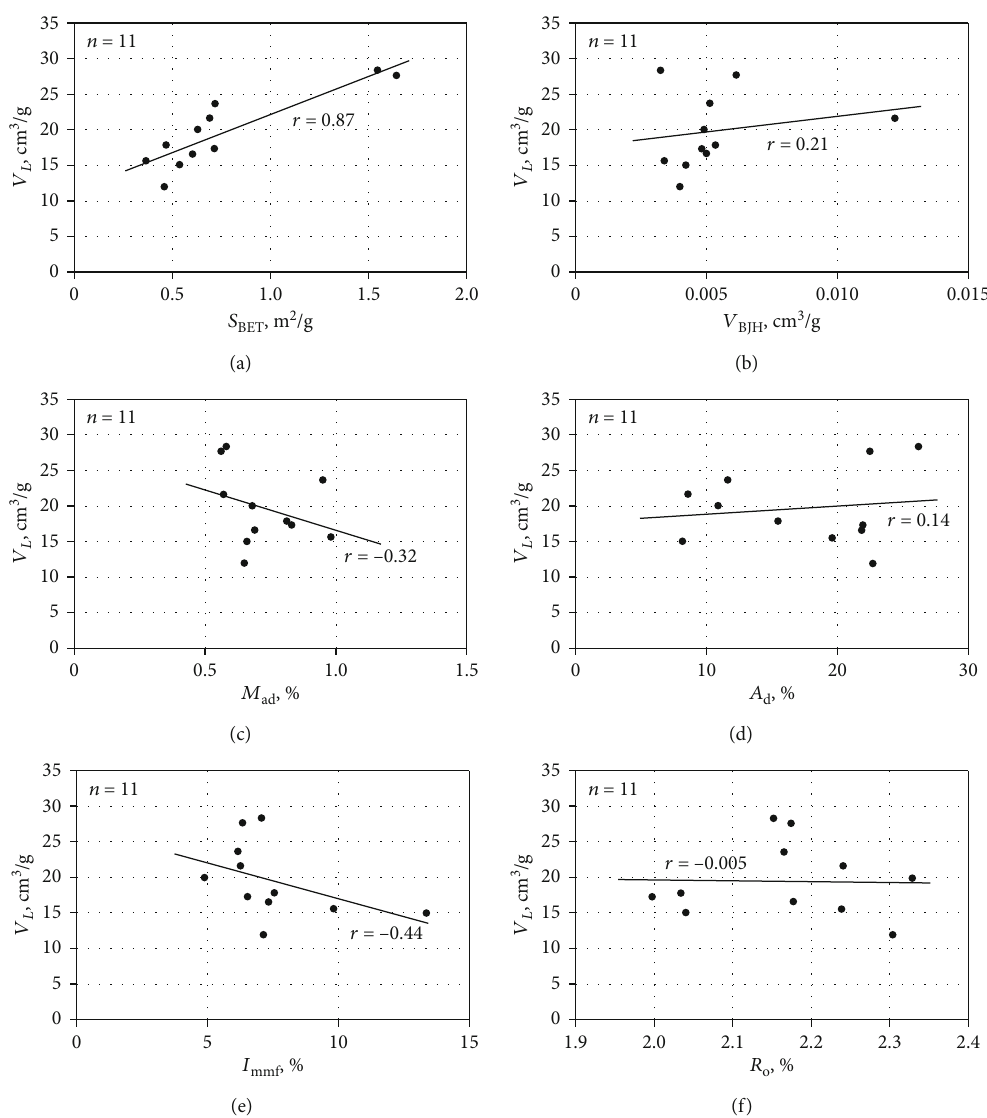
Figure 3: Scatter plots of (a) BET speci fi c surface area, (b) BJH pore volume, (c) moisture content, (d) ash content, (e) inertinite content, and (f) coal rank versus methane adsorption capacity of the No. 2